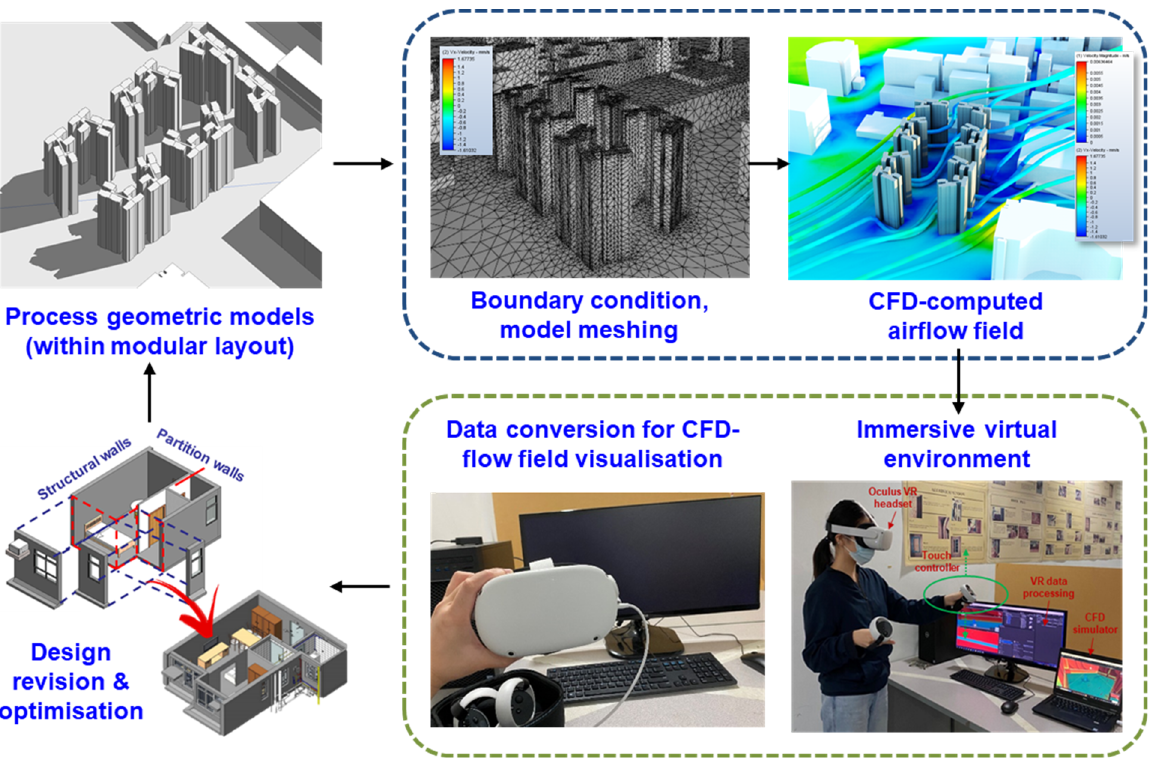
Figure 1. Overview of the proposed framework.